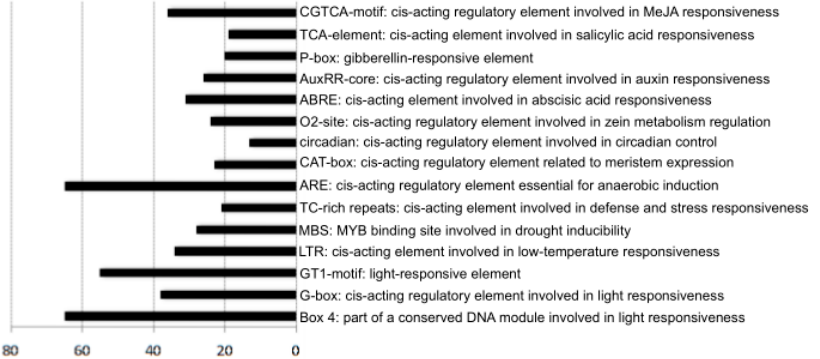
Figure 6. The main response cis ‐ acting elements in GbCYP promoters. Int. J. Mol. Sci. 2019 , 20 , x